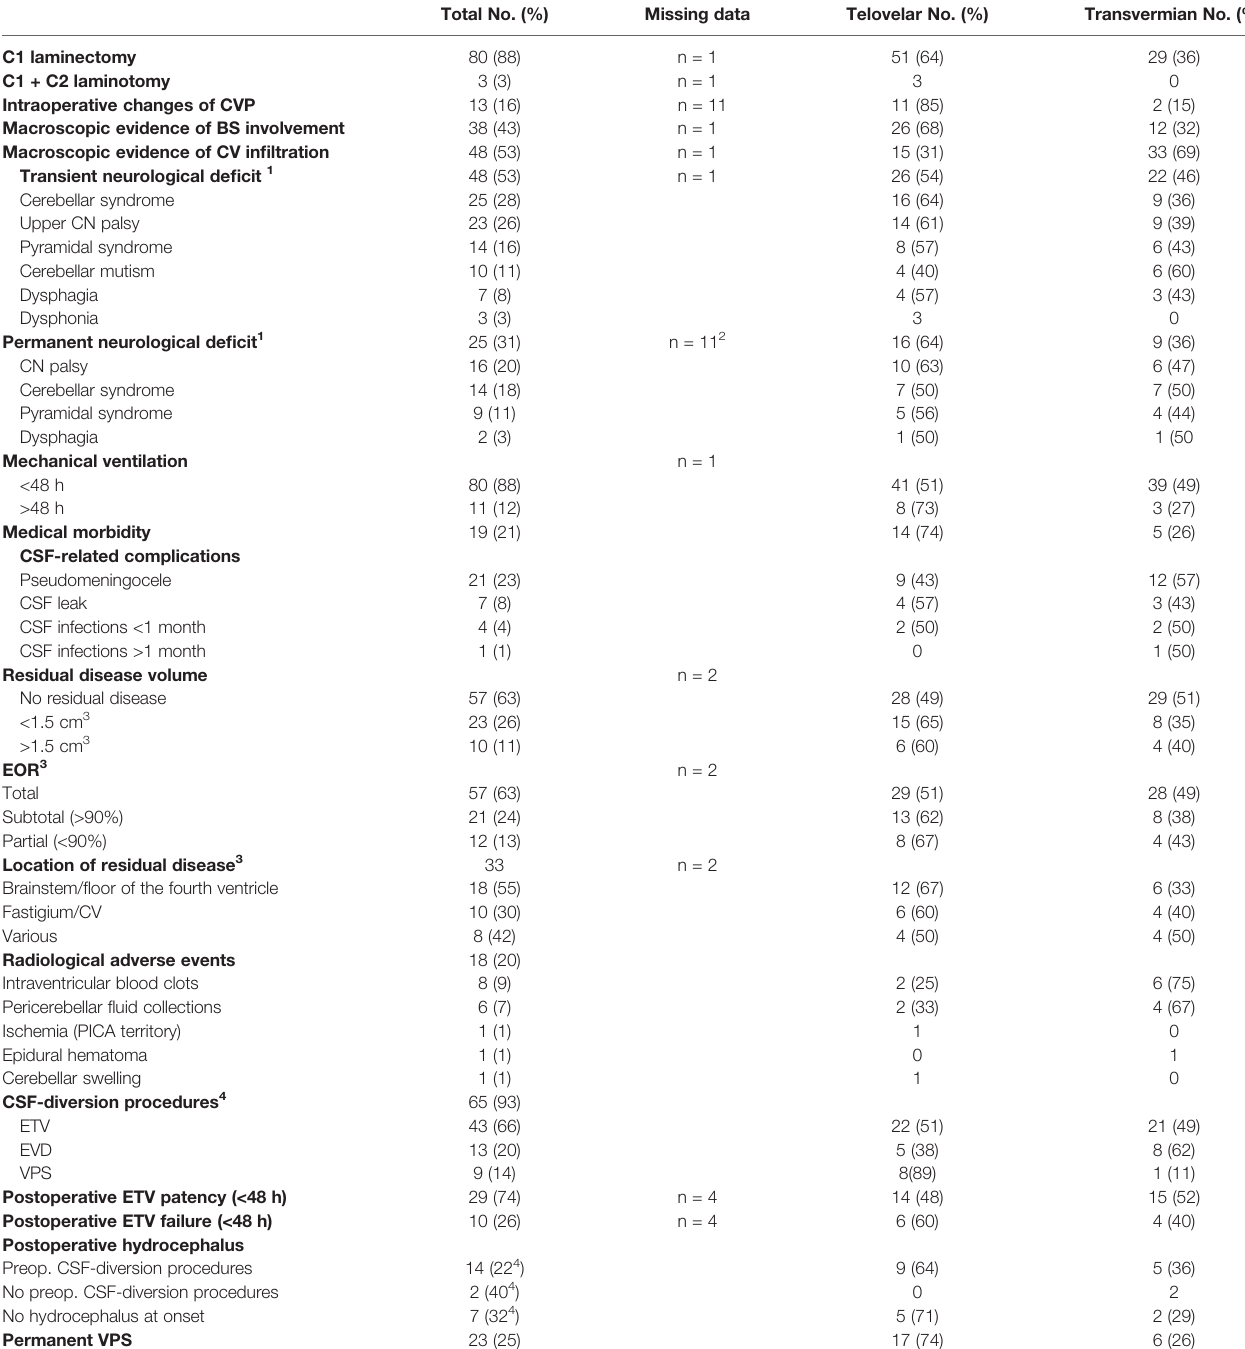
TABLE 2 | Surgery and postoperative clinical/radiological